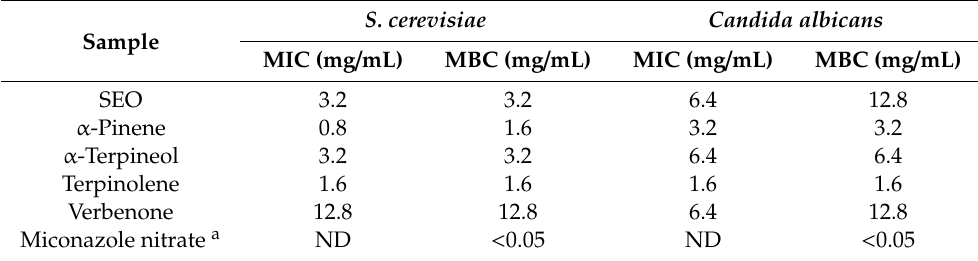
Table 4. Antifungal activities of SEO and the main